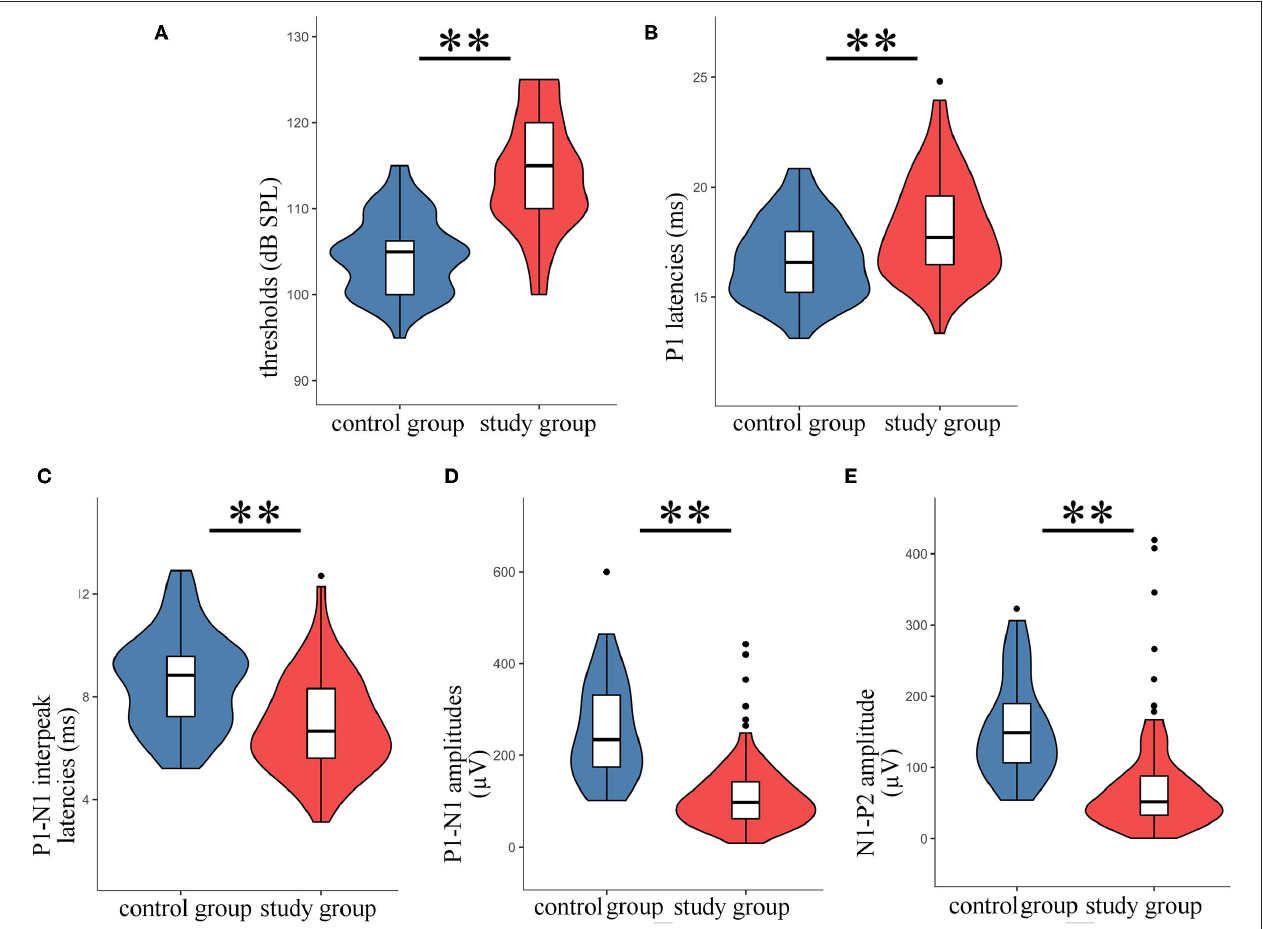
FIGURE 3 | The parameters of cVEMP in the study group were compared with those of the control group. The violin plot includes the box-whisker plot inside presenting the median, IQR, the upper limit (third quartile + 1.5 × IQR), and the lower limit (first quartile – 1.5 × IQR), and the violin outline presenting the density distribution (The mathematical predictions beyond the upper and lower limits were truncated because the boundary effect has no practical significance for this study.). (A) Thresholds; (B) p1 latencies; (C) p1-n1 interpeak latencies; (D) p1-n1 amplitudes; (E) n1-p2 amplitudes; ** t -test, p <